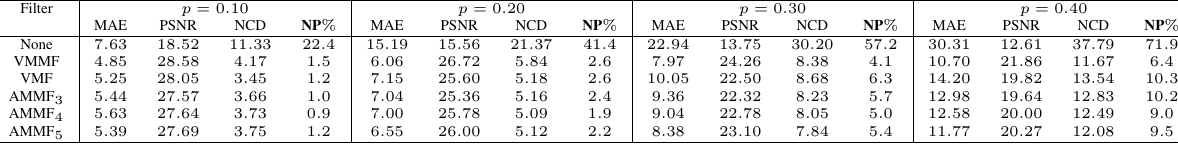
Table 2. Performance comparison in terms of MAE, PSNR, and NCD when filtering the Lenna image contaminated with random-value impulse noise with probability p in each colour channel.